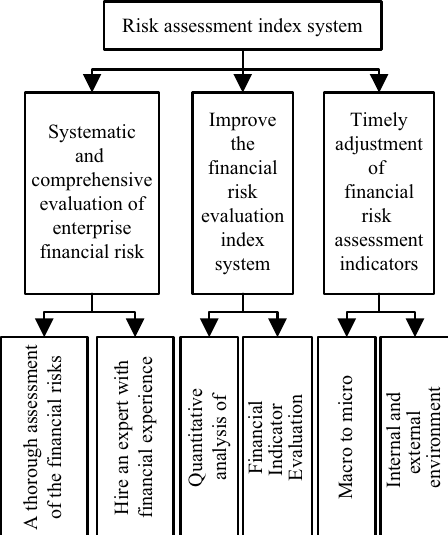
Figure 2: Risk assessment index